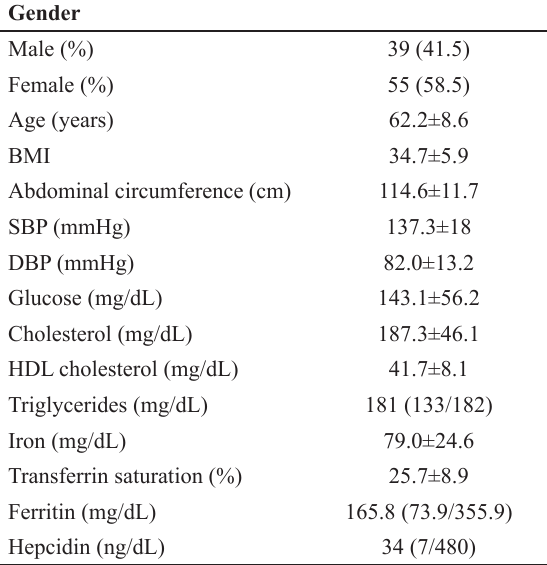
Patients demographics (n=94).